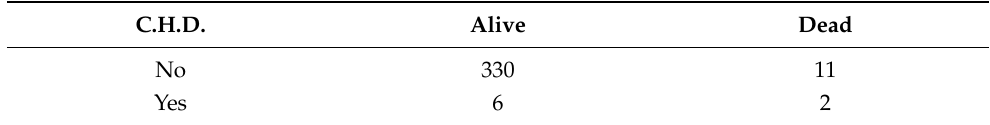
Table 7. Contingency table for exposure chronic heart disease to